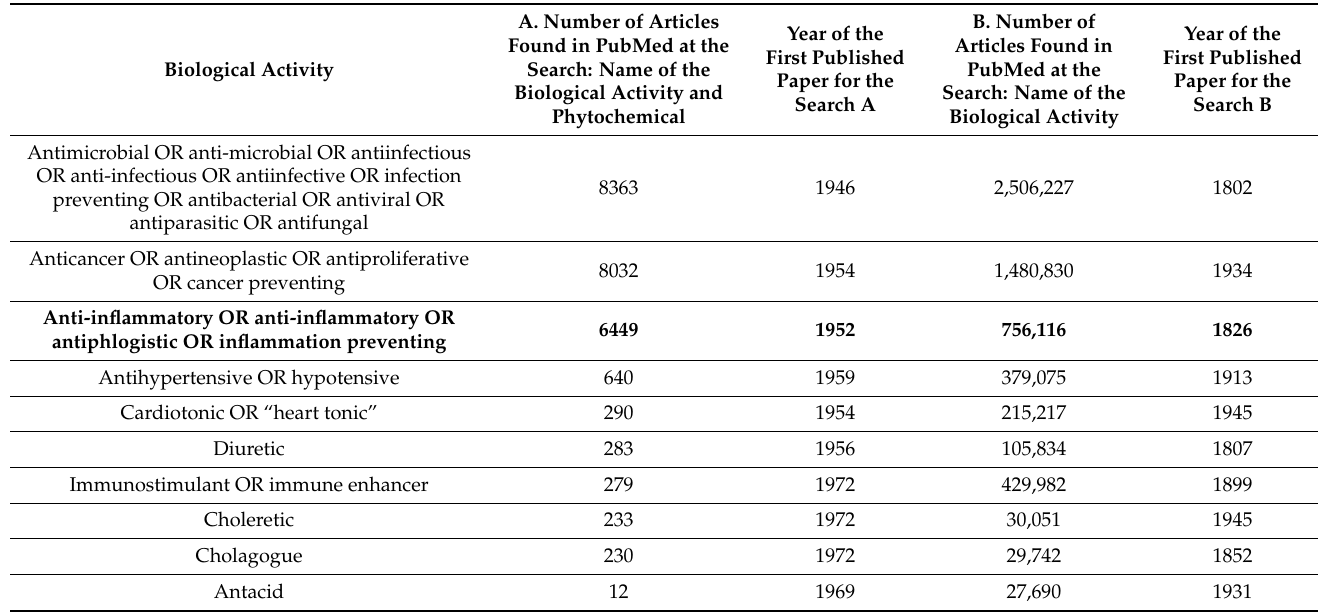
Table 4. Number of articles found in PubMed at the search on various biological activities of